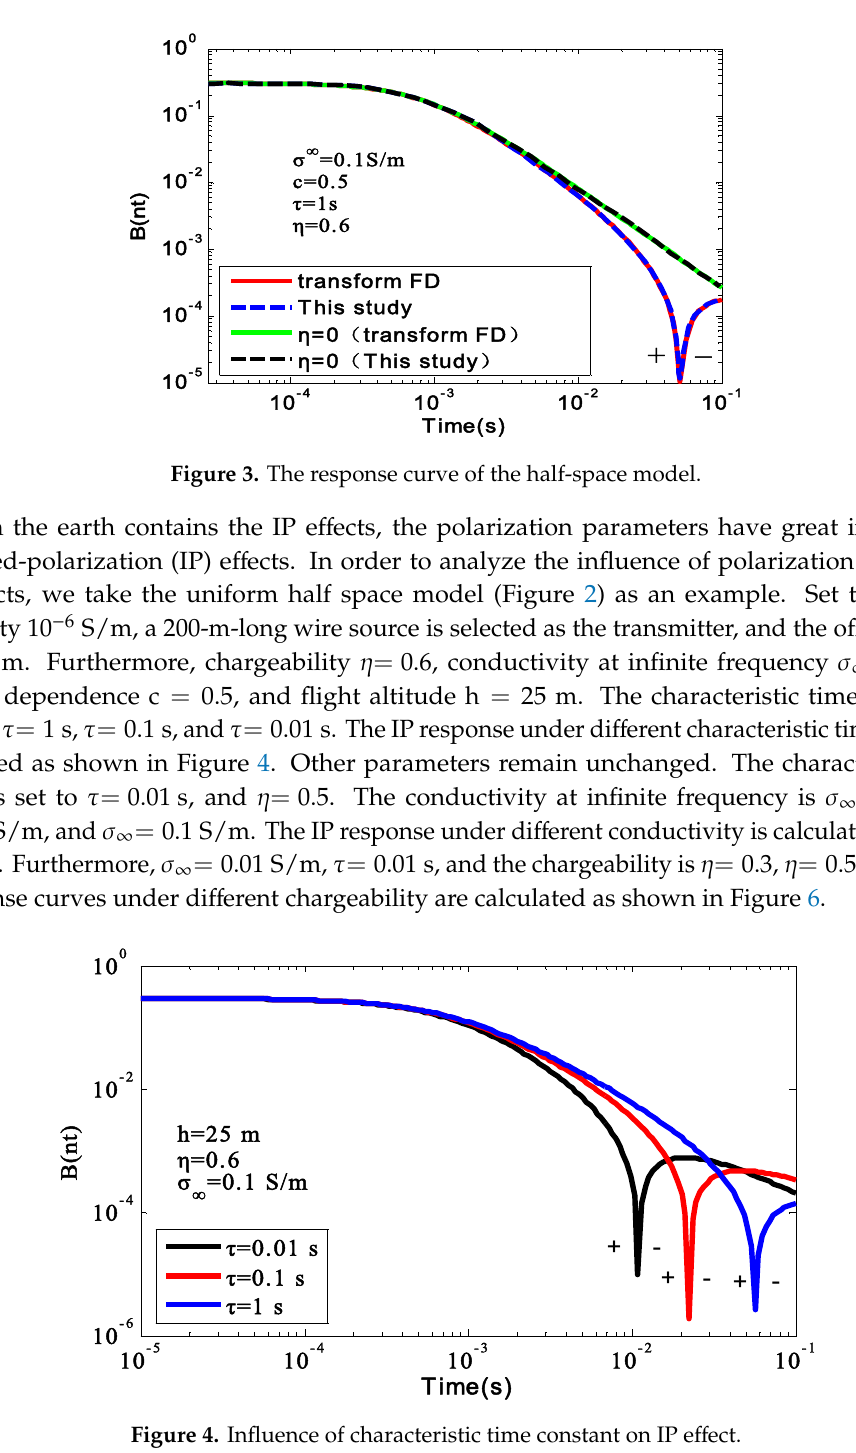
Figure 2. The half-space model with induced polarization (IP) effect.